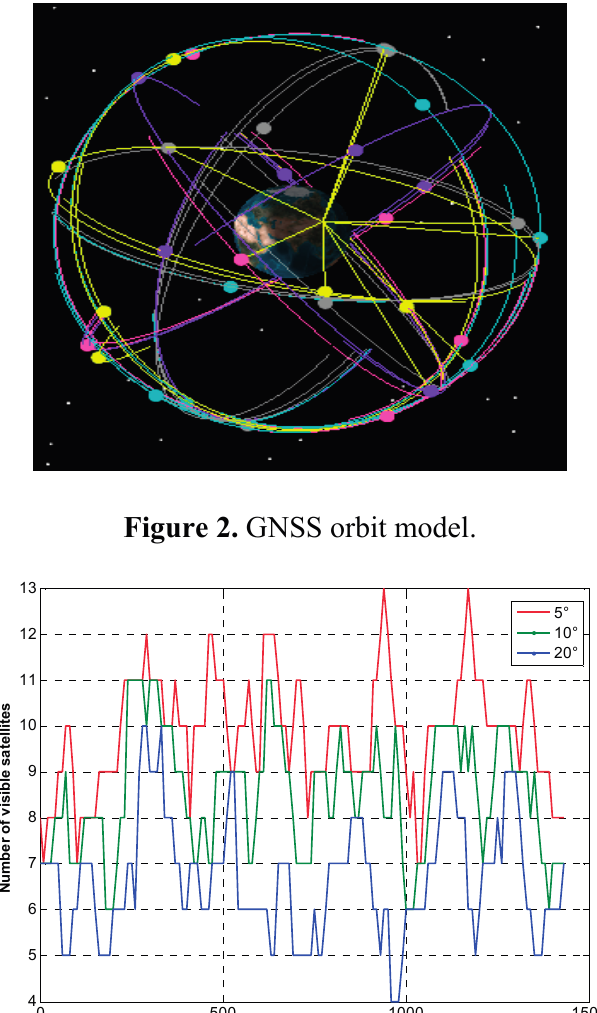
Figure 3. Visibility of GNSS satellites at different cutoff angles.